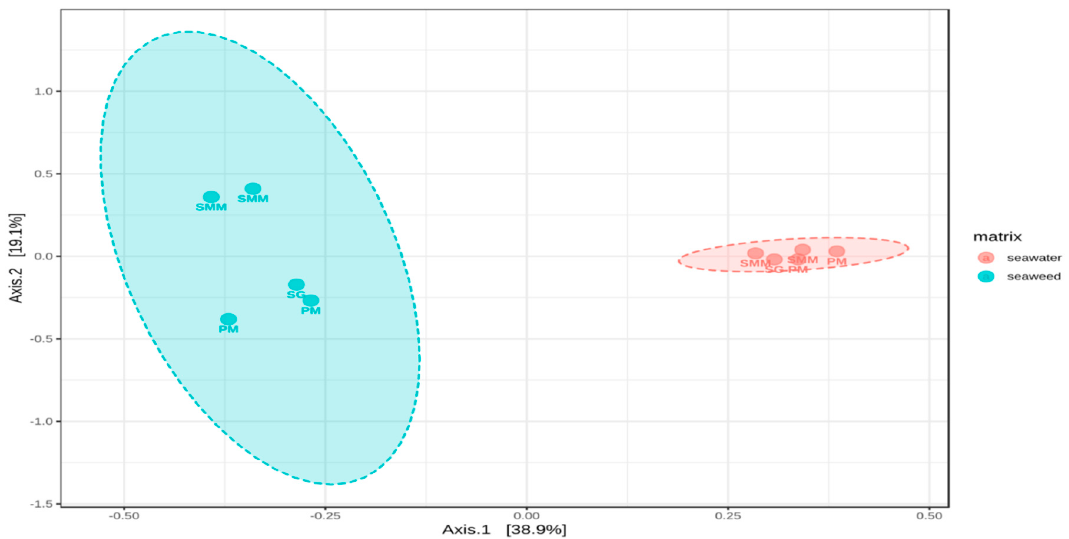
Figure 5. Principal coordinate analysis plot (PCoA) based on a Bray-Curtis distance matrix calculated from the square-root transformed ASV abundance data of the bacterial community on U. laetevirens and their surrounding seawater among sampling periods. SMM: Santa Maria del Mare, PM: Porto Marghera, and SG: San Giuliano.